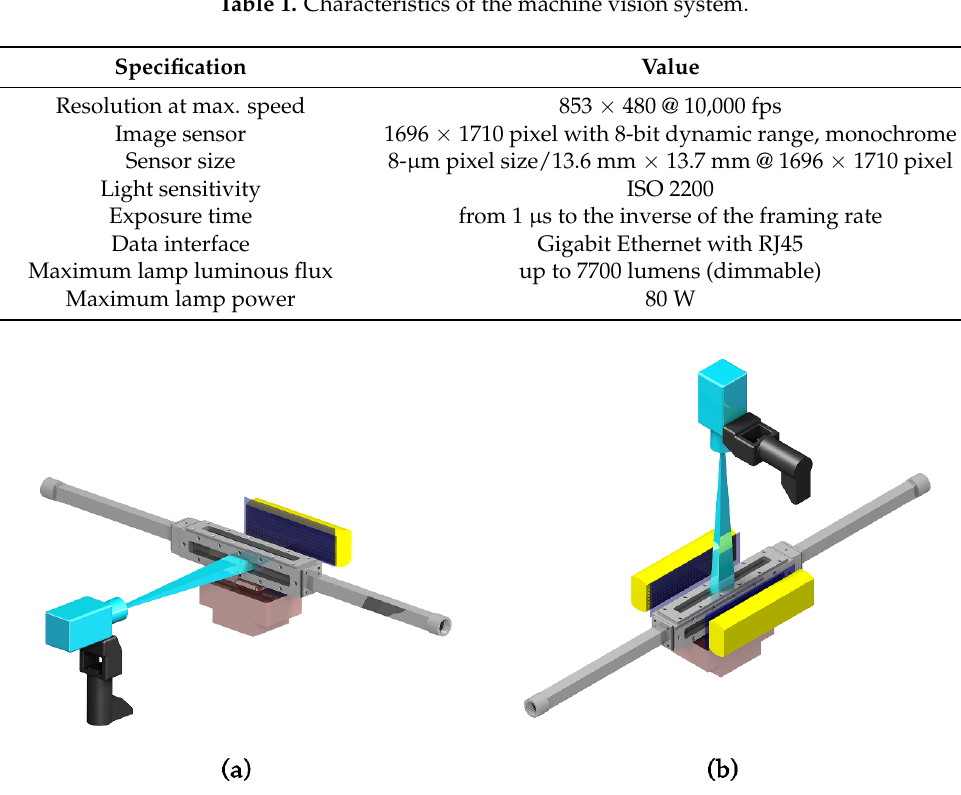
Figure 1. High-speed camera and lamp position: ( a ) side projection; ( b ) frontal